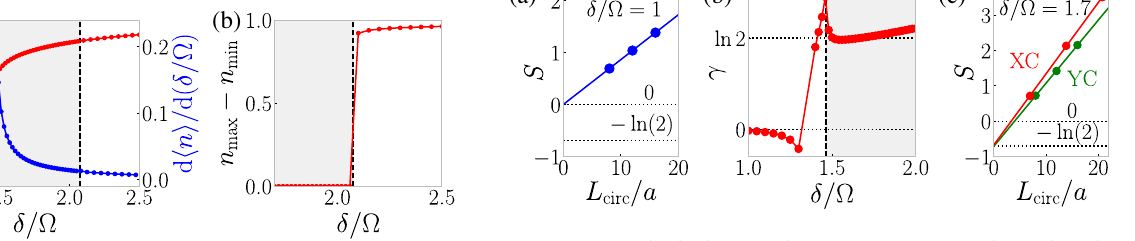
− 2 S L ¼ 4 , where ¼ 8 n ffiffiffi p =a ¼ 3 n ( 2 n circ